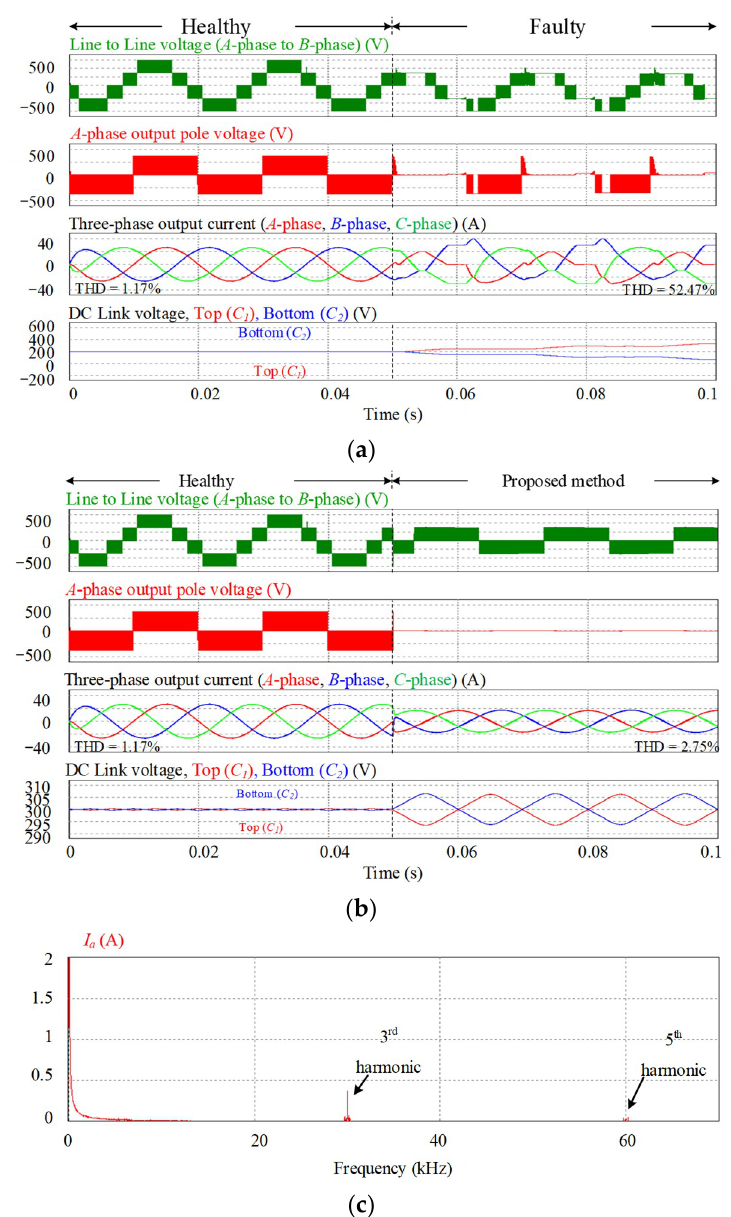
Figure 8. V ab , V an , three-phase currents, and DC link voltages when an open-circuit failure occurs at S a 1 / D a 1 healthy and faulty conditions ( a ) before applying the proposed method, and ( b ) after applying the proposed method. ( c ) The corresponding harmonic distribution after applying the proposed method.